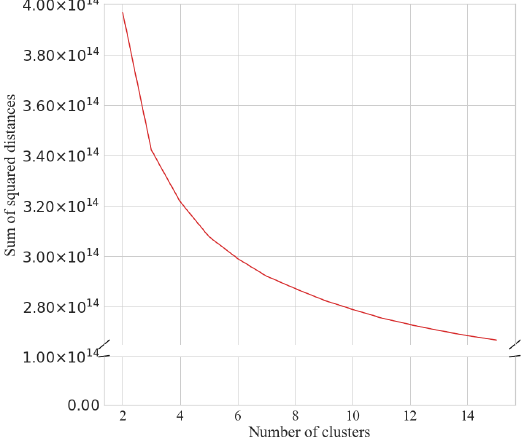
Figure 1. Elbow plot for determining the number of yearlong step behaviour clusters.